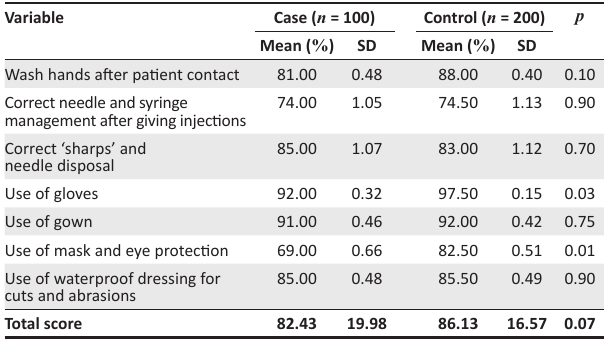
TABLE 3: Comparison of universal precautions practice scores among health care workers (cases and controls) ( N =